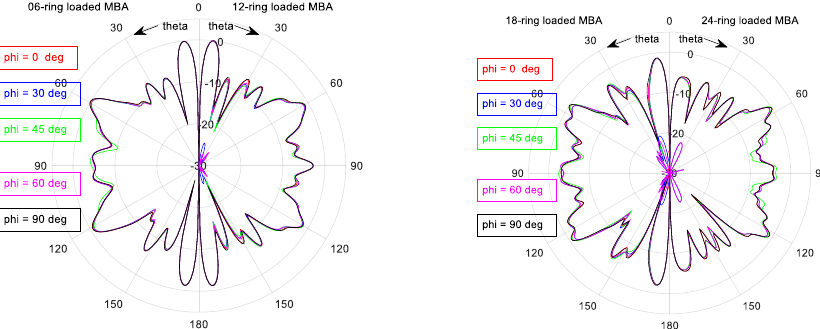
Figure A4. 2D patterns at 17 GHz of 6-, 12-, 18- and 24-ring-loaded MBA in different cutting planes.